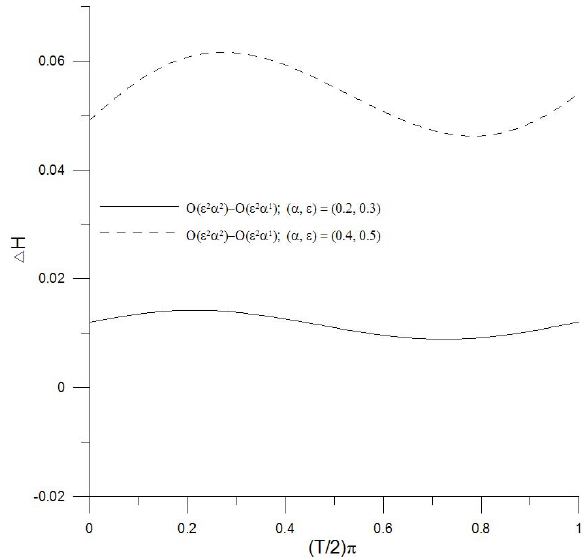
Fig. 5a. Differences between second-order α and first-order α ap- proximations for order ε 2 when ( α , ε )=(0.2, 0.3) and ( α , ε )=(0.4, 0.5).